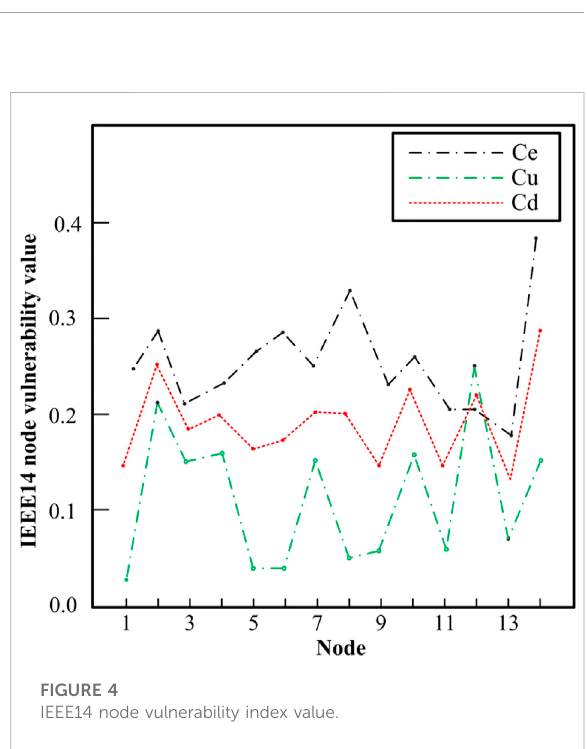
FIGURE 4 IEEE14 node vulnerability index